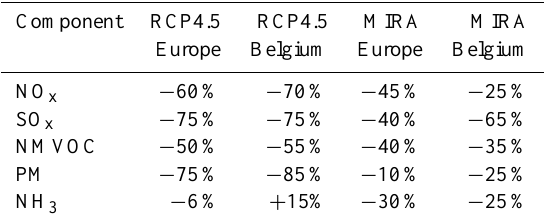
Table 1. Overview of the applied emission changes from anthro- pogenic sources and biomass burning between the present day (2000–2009) and the near future (2026–2035). Component RCP4.5 RCP4.5 MIRA